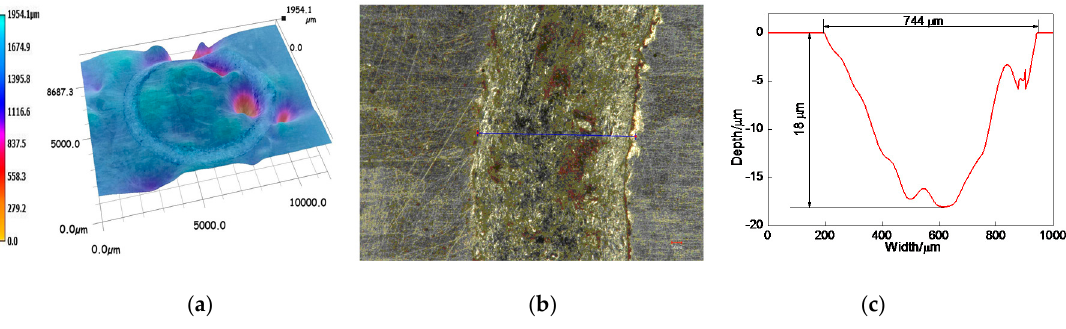
Figure 13. Profile of worn track on 20% Cr–80% Ni coating. ( a ) Overall profile of worn track; ( b ) Measured position of worn track; ( c ) Profile of worn track.